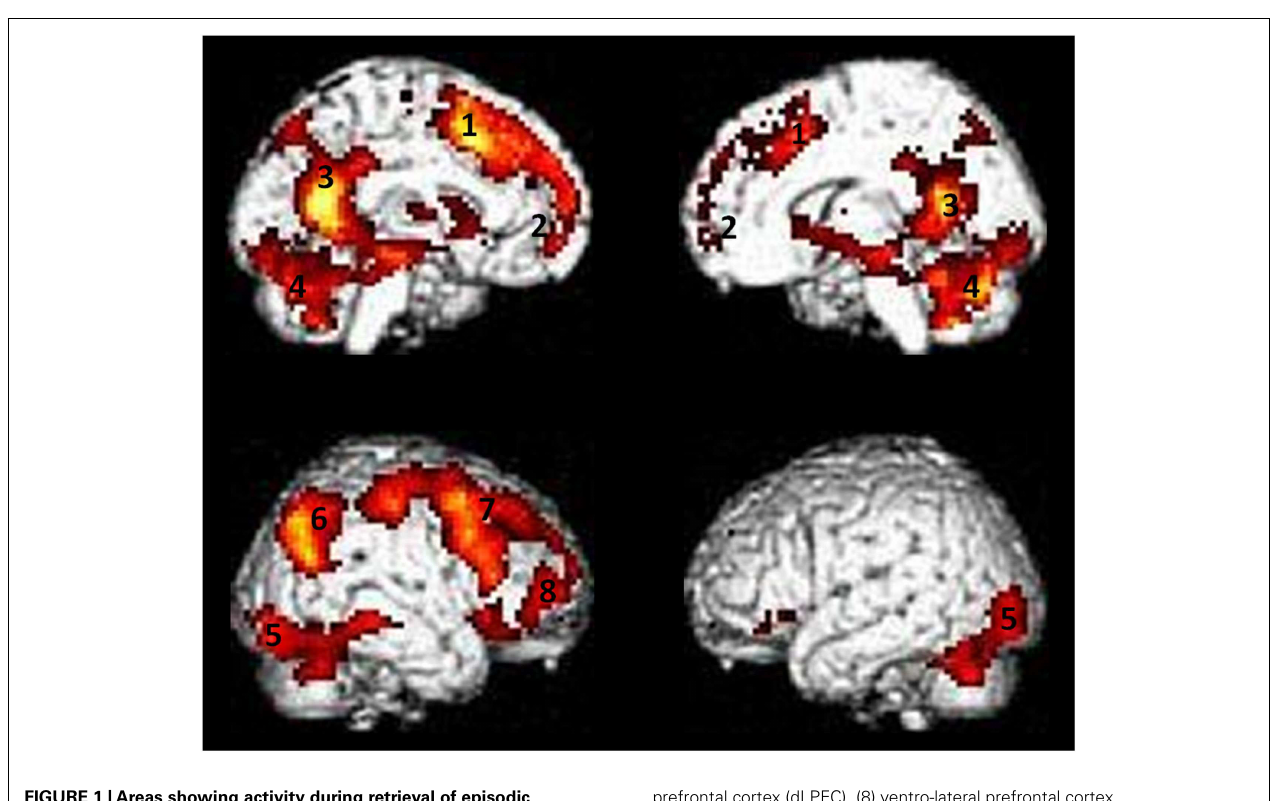
FIGURE 1 |Areas showing activity during retrieval of episodic autobiographical memory . (1) Dorsal anterior cingulate cortex (dACC), (2) medial prefrontal cortex (MPFC), (3) posterior cingulate cortex/precuneus (PCC/precuneus), (4) cerebellum, (5) occipital cortex, (6) posterior parietal cortex (PPC), (7) dorso-lateral